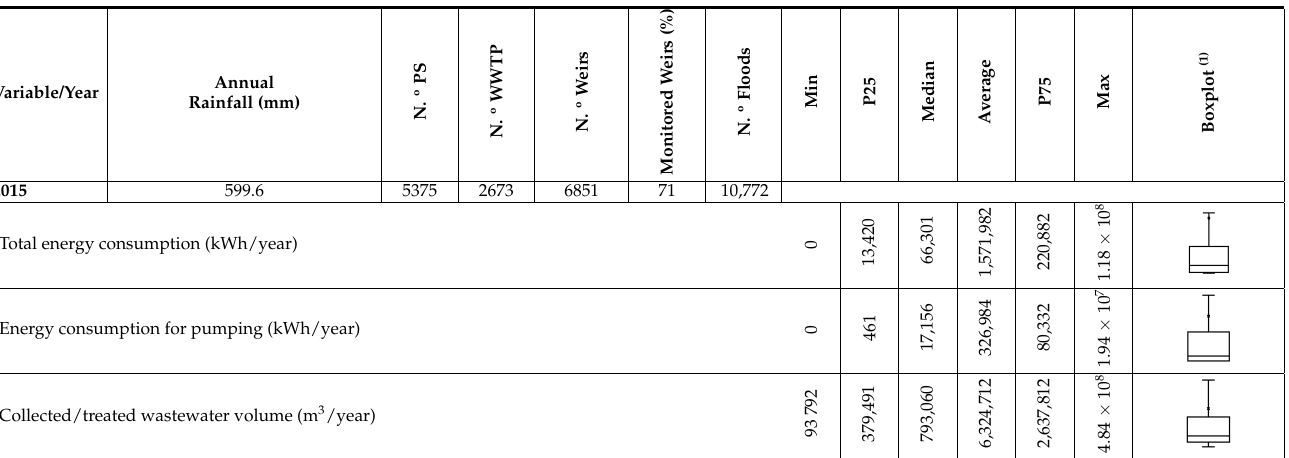
Table A3. National characterization for the evaluation of the W ‐ E ‐ G nexus for 2016.